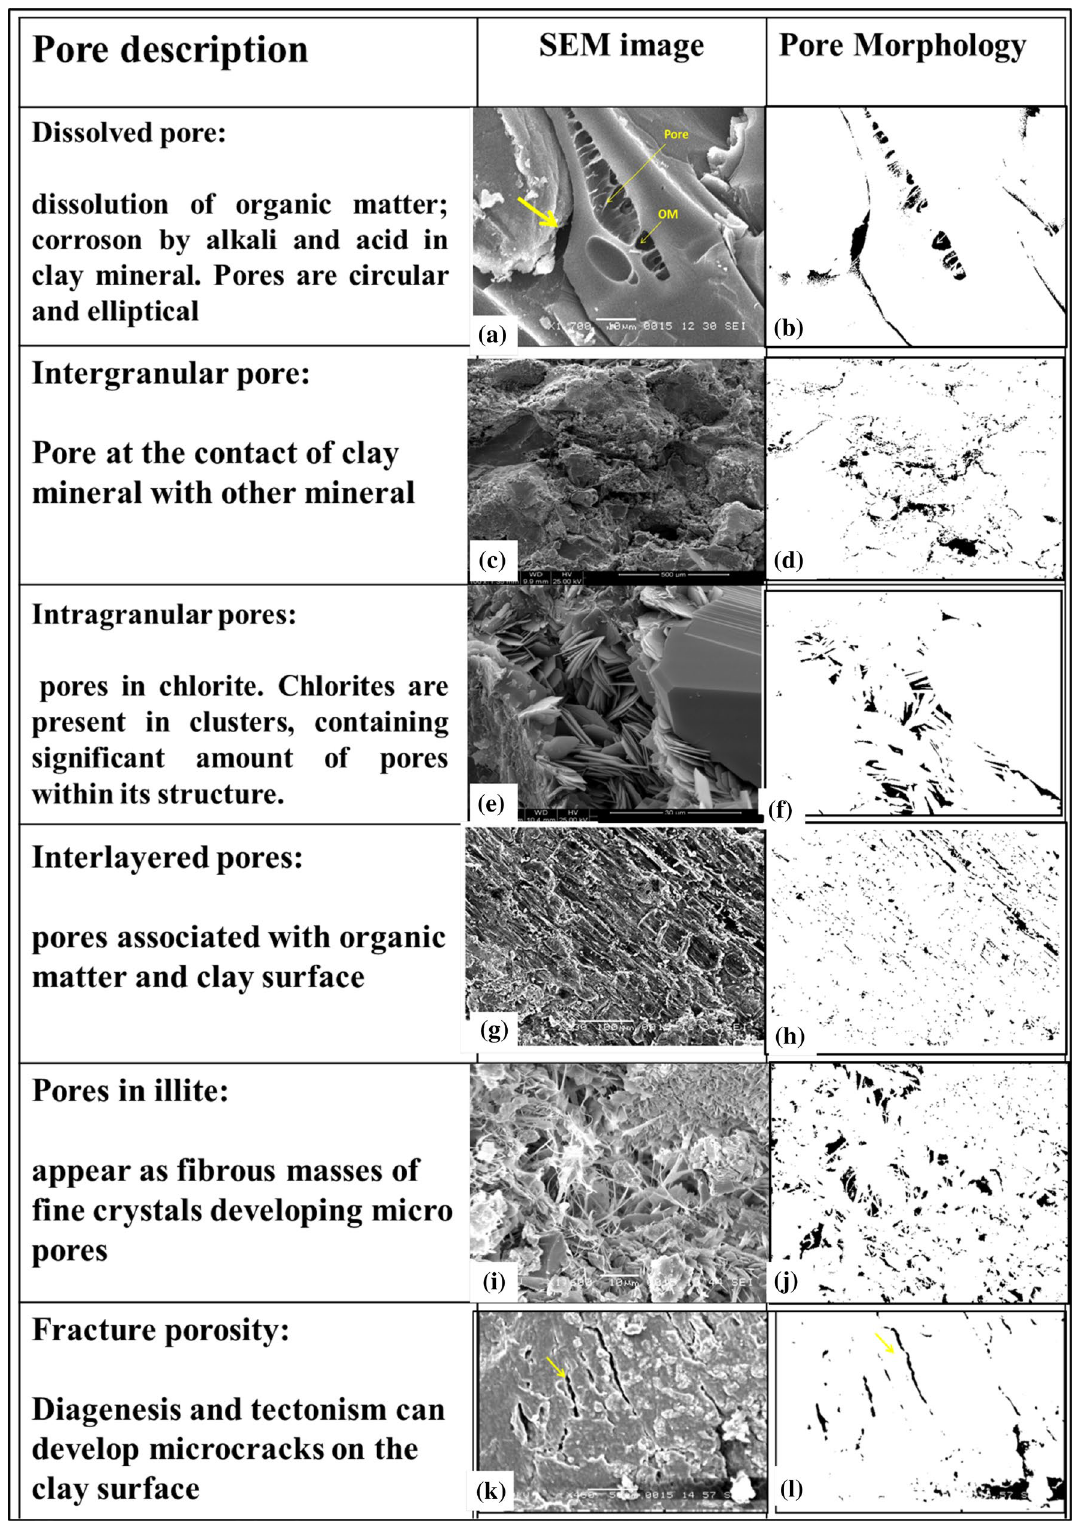
Fig. 5 Morphology and classification of pores in shales. a Dissolved pores, c intergranular pore, e intragranular pores, g interlayered pores, i pore in illite, k fracture porosity. b, d, f, h, j The pore distribution and network of SEM images a, c, e, g and h ,